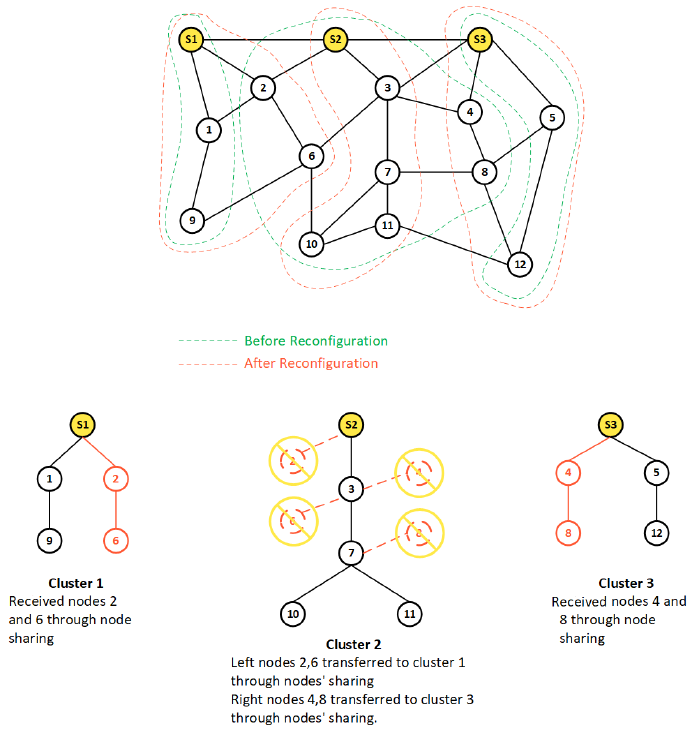
Figure 5. Node-sharing